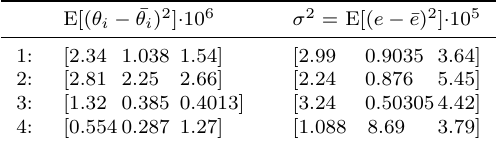
Table 9: Cases 1 to 4, mean and variance-of-error for estimator for ˆ θ i , ˆ f 1 ,i , i = [2 , 3 ,